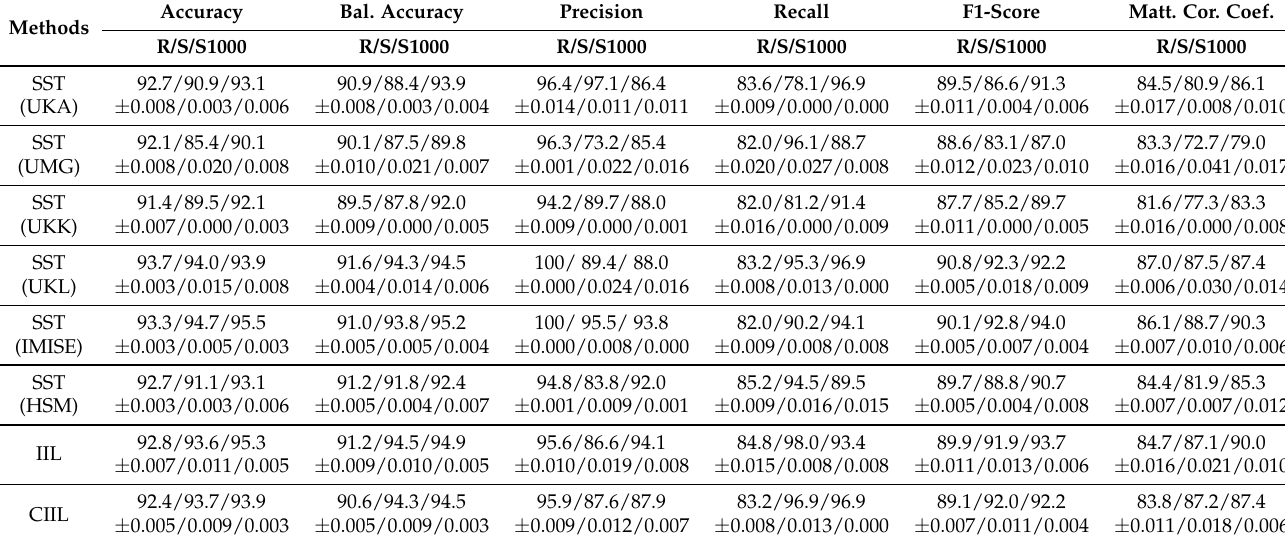
Table 2. Results in IID setting (equally-sized and balanced class distribution). The meaning of the abbreviations are: real-world data (R), synthetic data (S) and synthetic data with the generation size of 1000 (S1000).